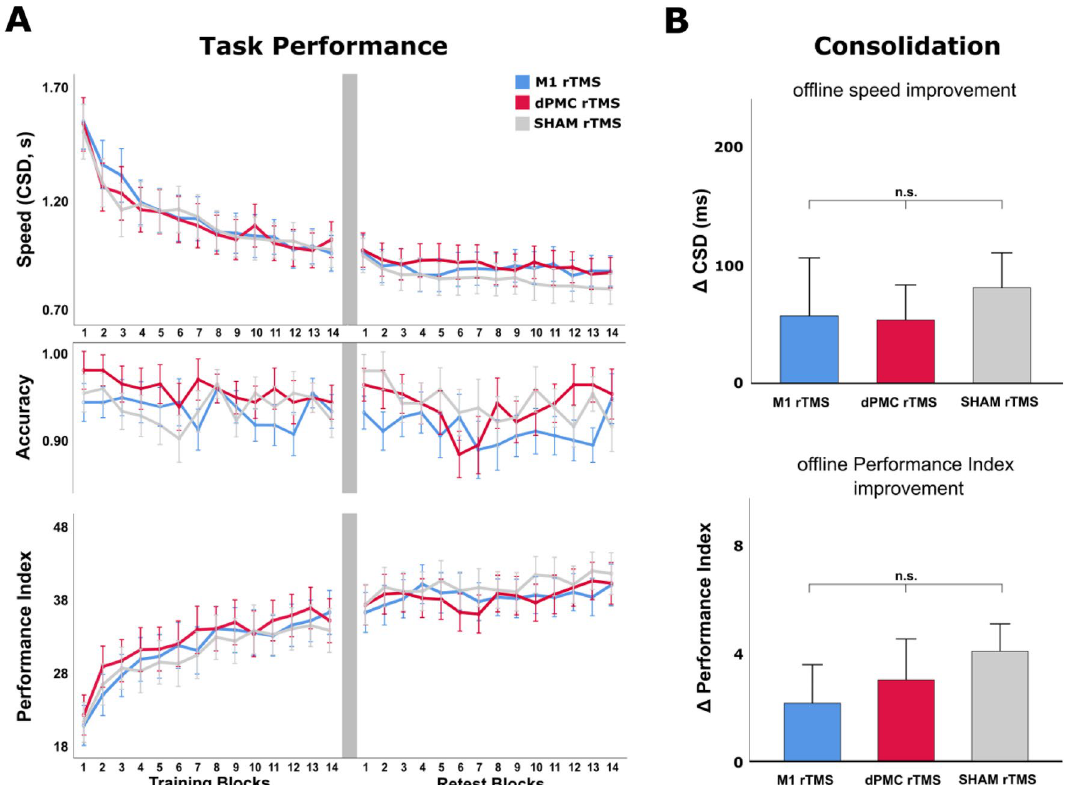
Figure 3. Behavioural results. ( A ) Performance changes of all three experimental groups (post-training M1 rTMS, dPMC rTMS, and SHAM rTMS) across blocks of task execution in terms of speed (mean duration of a correct sequence, CSD), accuracy (ratio of the number of correct sequences per block/number of maximum correct sequences per block), and the combined performance index. The grey column between the training and retest graphs represents the 8-h break interval. Error bars indicate the standard error of the mean. ( B ) Offline task performance changes (difference) between end-of-training (mean performance across the last 4 blocks of the training session) and beginning of the delayed retest (first block of delayed retesting). Note that differences were computed such that positive values indicate offline performance improvements (i.e., offline learning). Error bars indicate the standard error of the mean (n.s.: not